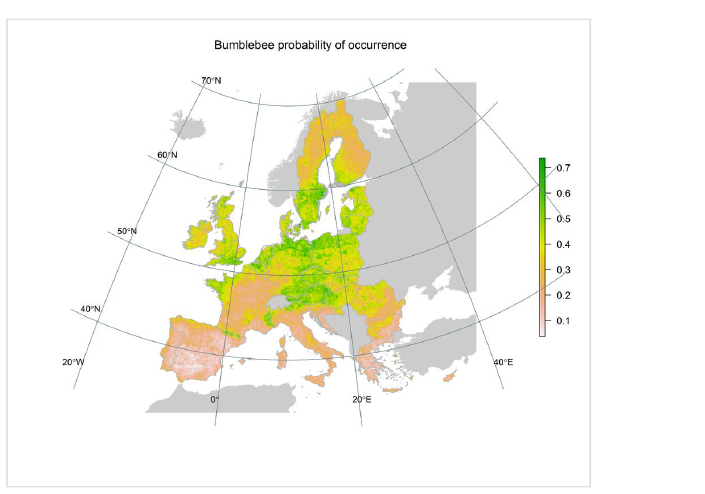
Figure 2. Predicted probability of occurrence for bumblebees, resulting from the individual species distribution maps. Single species distribution maps were summed and their average extracted by dividing it by the species richness map (Fig. 1). Hence, for each map locality, the average probability of occurrence was based only on the number species predicted to be